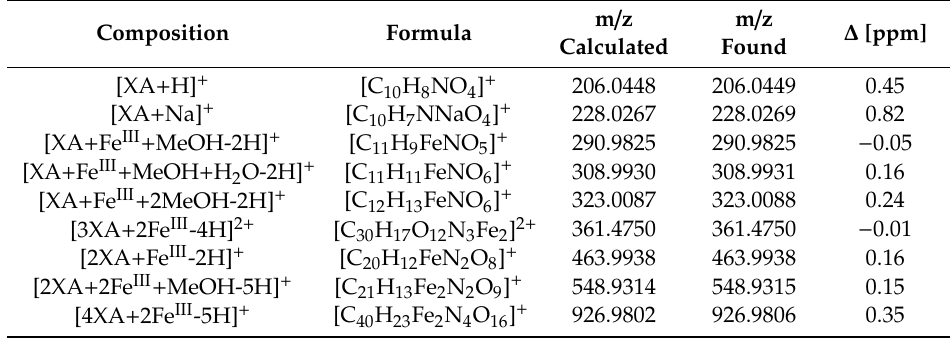
Table 3. The main signals of 56 Fe-XA coordination complexes in the solutions of XA with Fe III analyzed by nano-ESI-MS; a positive ionization